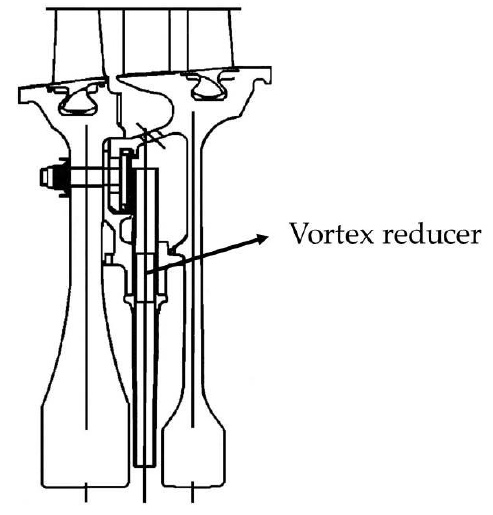
Figure 1. Schematic diagram of vortex reducer.